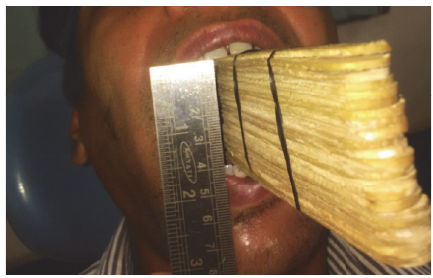
Figure 8: 30th postoperative day ice cream sticks assisted mouth opening—40